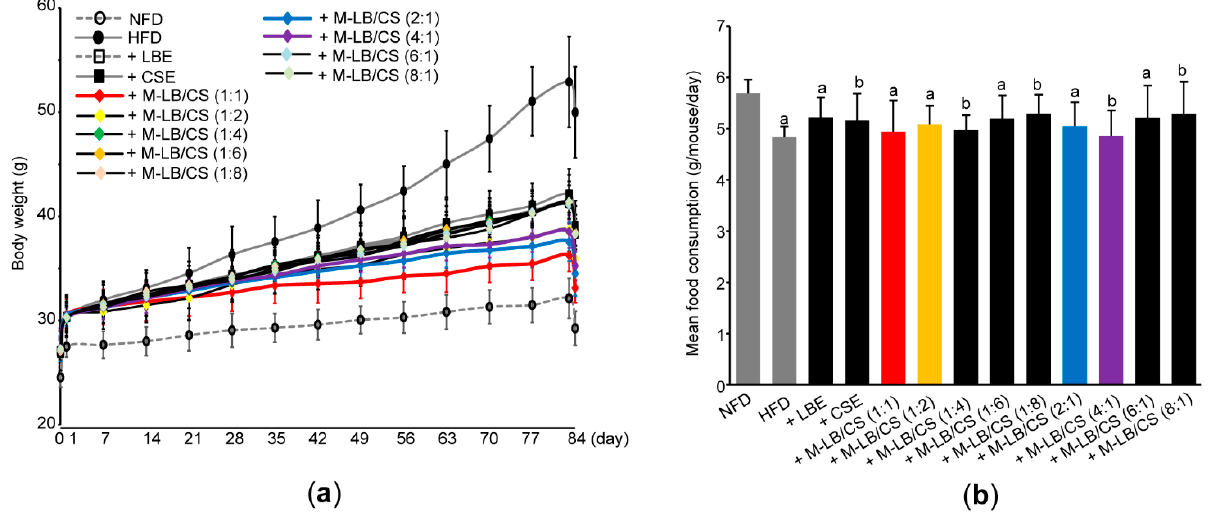
Figure 2. Mixture of lemon balm and corn silk extracts (M-LB/CS) reduced body weight gain in mice fed a high-fat diet (HFD). ( a ) Changes in body weight during the experimental period. Mice were fed an NFD or HFD and administered with LBE, CSE, or various combination ratios of M-LB/CS, as described in the Materials and Methods Section. All mice were fasted for 12 h on days 0 and 84. ( b ) Mean daily food consumption. a p < 0.01, b p < 0.05, vs. NFD; NFD—normal fat diet.